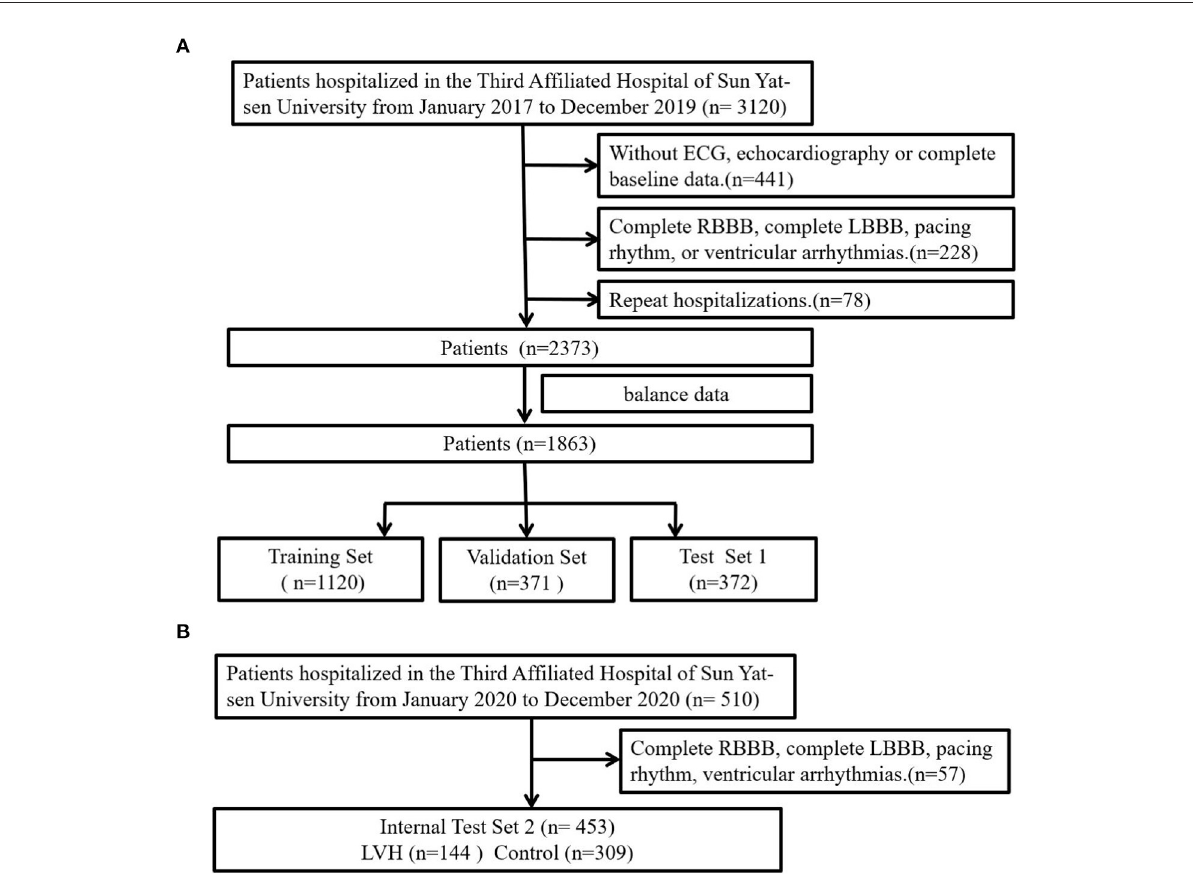
FIGURE1 Study flow diagram. (A) The first cohort was further divided into training, validation and test sets. (B) The second cohort was used as internal test 2 to evaluate developed DL